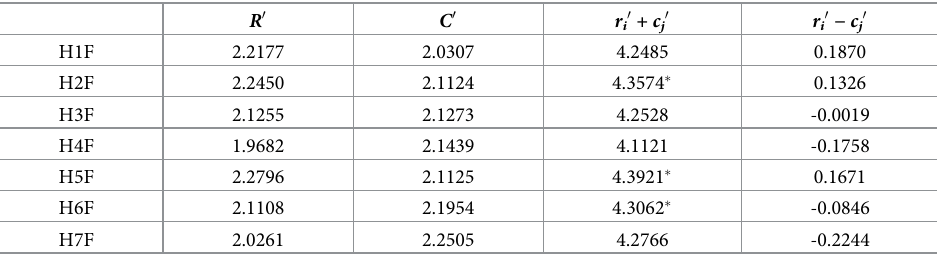
Table 7. The value of R 0 & C 0 and identify cause and effect group.